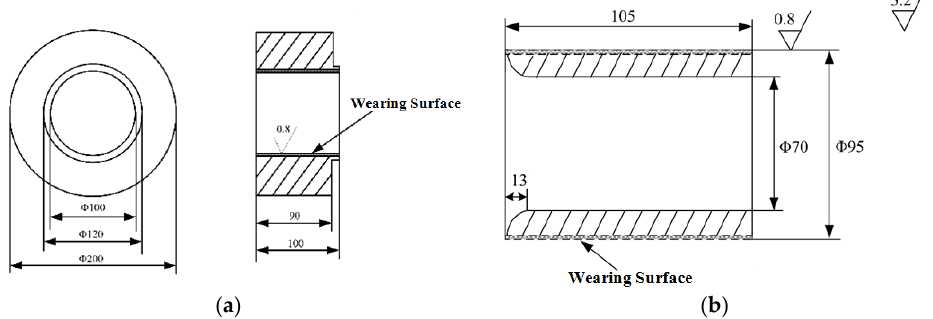
Figure 1. Schematic illustration of the typical dimensions of a sink-roller assembly at the continuous zinc galvanising production lines in steel mills: ( a ) bushing and ( b ) sleeve pipe.